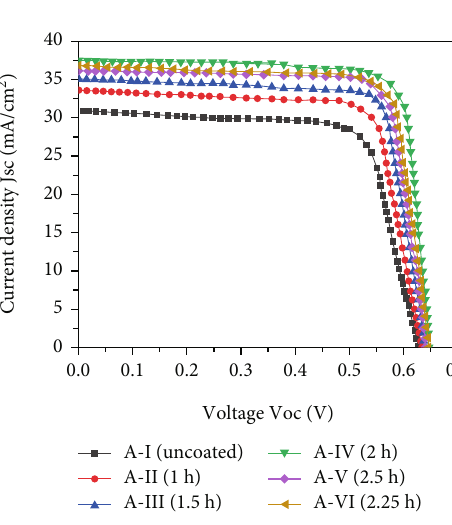
Figure 9: I-V plot of the samples under controlled source